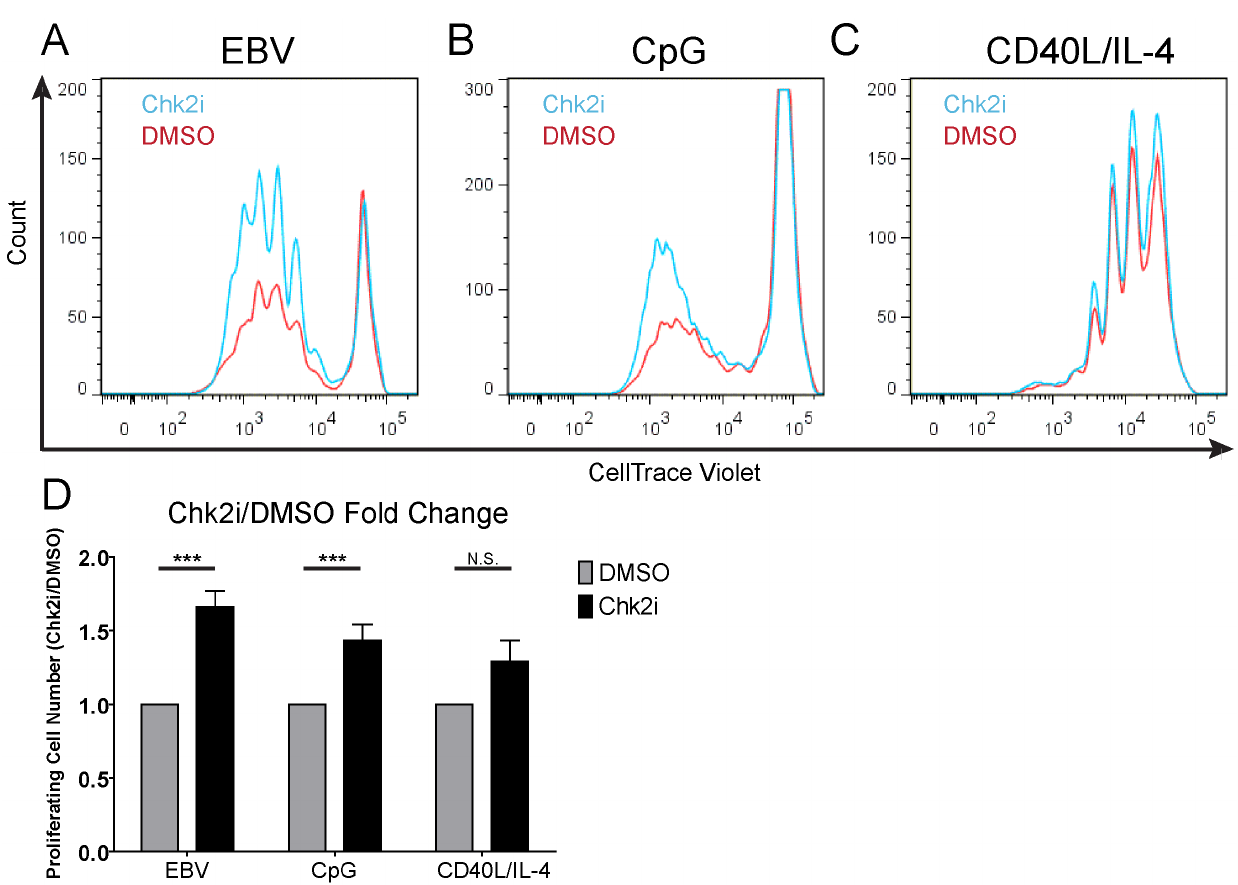
Figure 3. Chk2 inhibition increases proliferation of human B cells. FACS profile of (A) EBV infected (B) CpG or (C) CD40L/IL-4 treated CD19 + cells at the day of peak proliferation post infection/stimulation in the presence of DMSO (red) or 5 m M Chk2i (blue). For EBV this was day 8 post infection, CpG was day 7 post stimulation, and CD40L/IL-4 was day 6 post stimulation. (D) Relative number of proliferating CD19 + cells were gated and counted over internal beads control and normalized to DMSO-treated sample on the days described in (A–C). Experiment was repeated on PBMC from 3–6 normal donors. Error bars are SEM. Significance of Chk2i treatment compared to the DMSO control was calculated via Student’s t test; ***, P - value , 0.01; N.S., not significant. CD40L/IL-4 treatment trended towards significance with a P -value of 0.078.